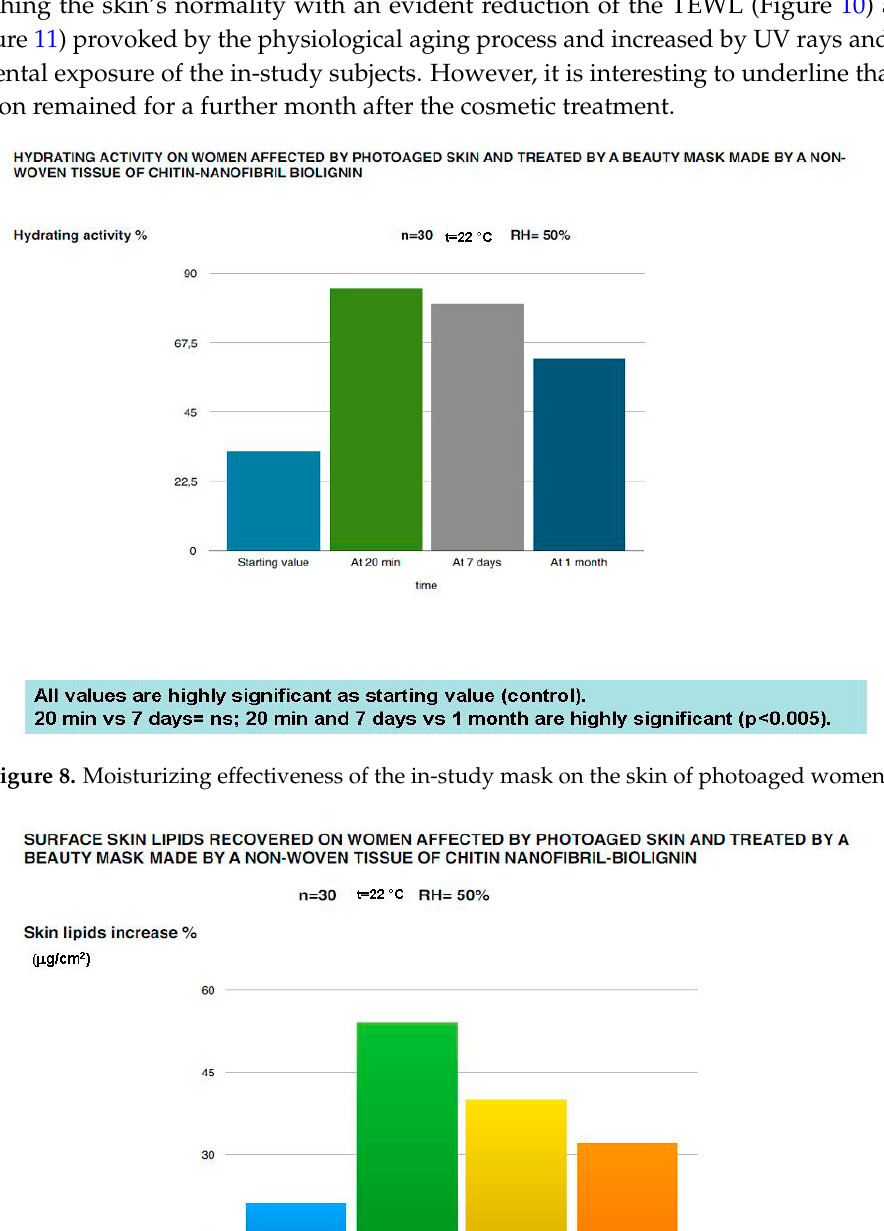
Figure 10. Effectiveness of the in-study mask on the TEWL balance of photoaged women.